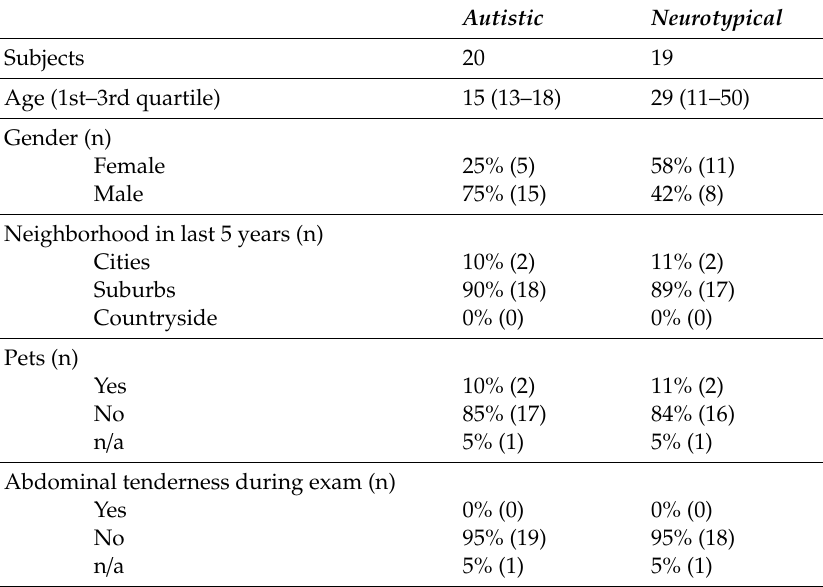
Table 1. Characteristics of study participants and microbiome lifestyle